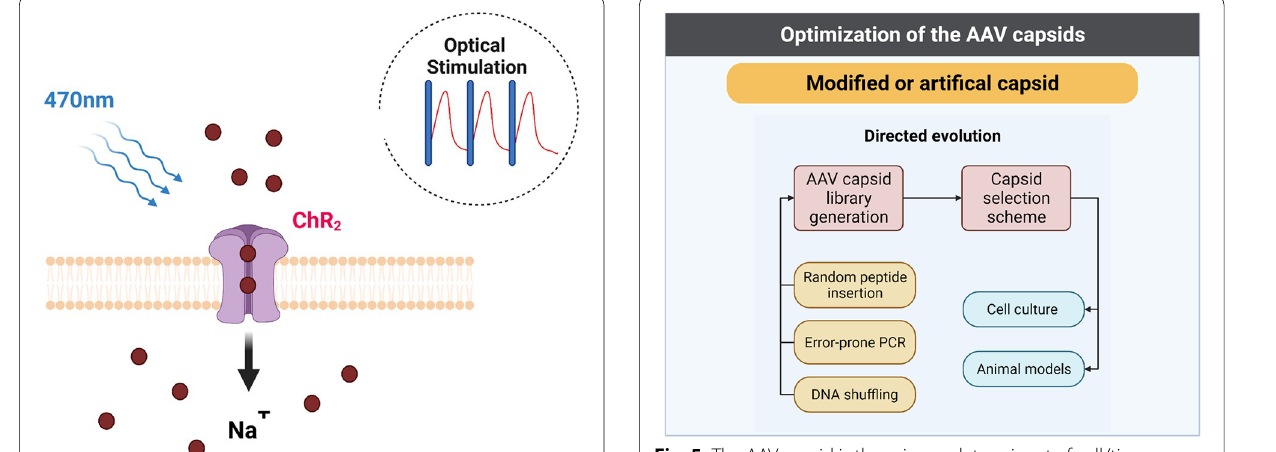
Fig. 5 The AAV capsid is the primary determinant of cell/tissue